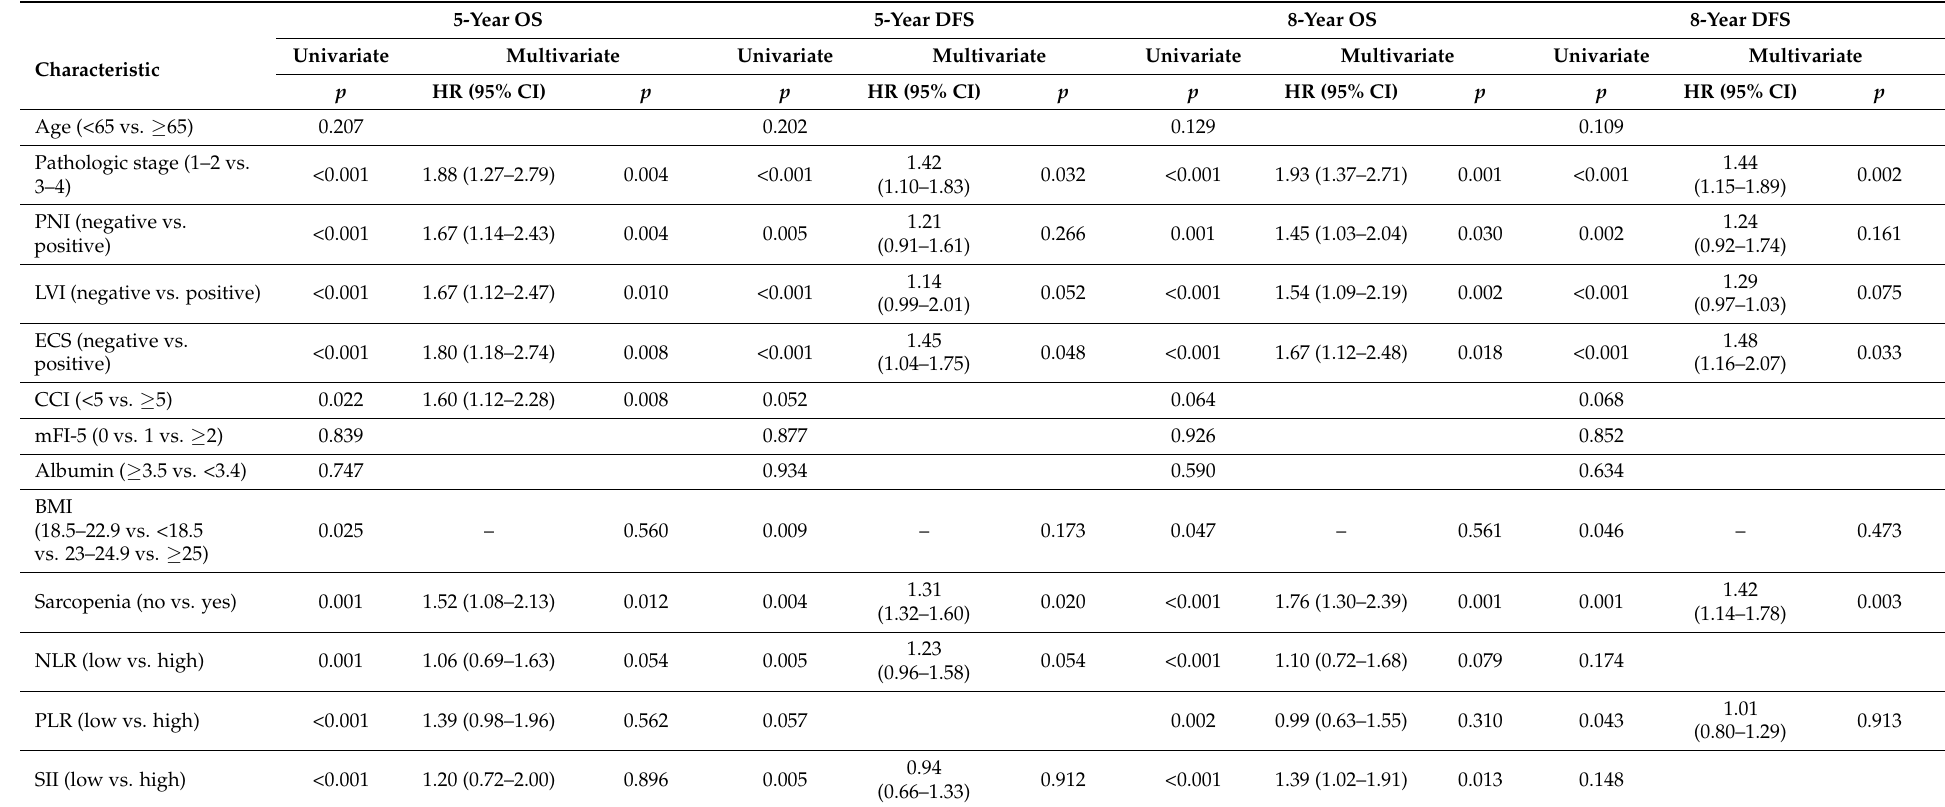
Table 6. Cox proportional hazards regression of clinical risk factors associated with